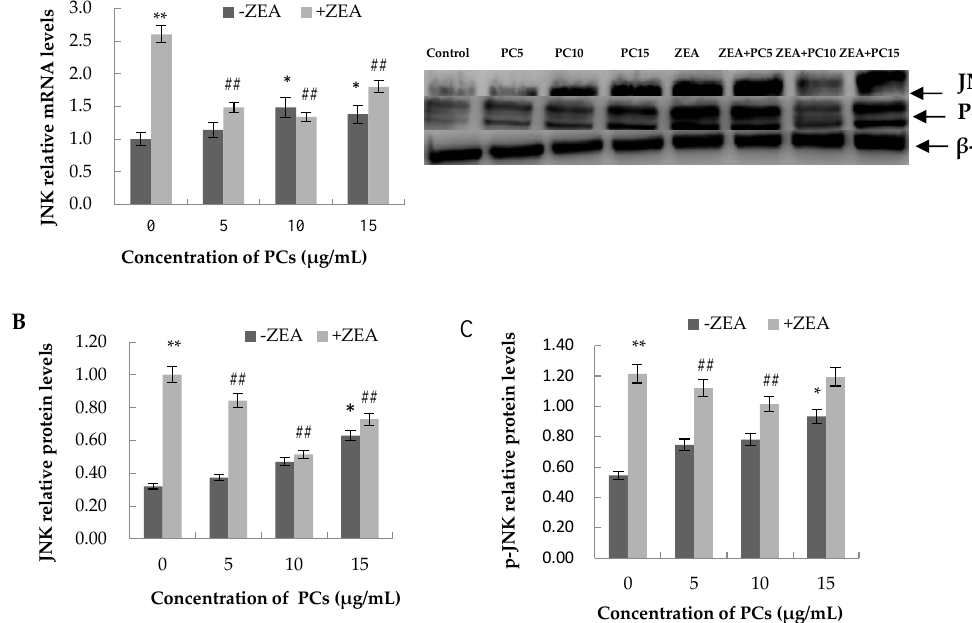
Figure 14. Effects of different concentrations of proanthocyanidins (PCs) on zearalenone (ZEA)-induced relative expression of mRNA and c-Jun N-terminal kinase (JNK) protein ( A and B ) in MODE-K cells, and the relative expression of p-JNK protein ( C ). PCs could significantly reverse the ZEA-induced increase in expressions of JNK and p-JNK. When the concentration of PCs was 10 μg/mL , PCs could significantly decrease the increase in protein expressions induced by ZEA. * p < 0.05 and ** p < 0.01 vs. control group; # # p < 0.01 vs. ZEA-treated group.